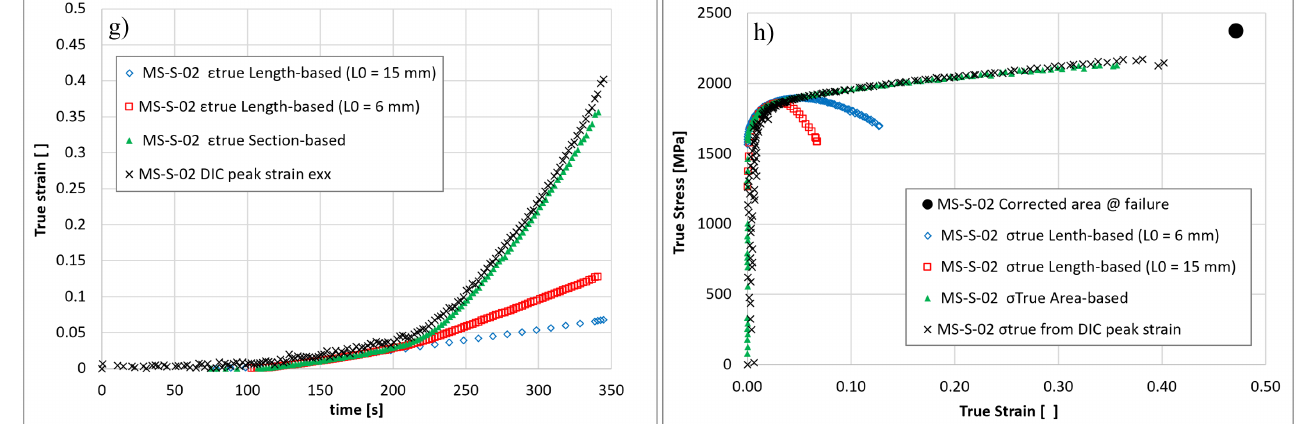
Figure 10. Evaluation of strain histories and true stress-strain curves according to the four procedures (length-based with two different gage lengths, area-based, DIC peak strain, and corrected area at failure) for two static tests of each metal, i.e., DP-S-01 ( a , b ), DP-D-02 ( c , d ), MS-S-01 ( e , f ), MS-S-02 ( g , h ).